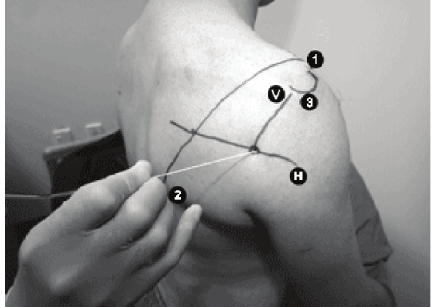
Figure 8: Price technique for the axillary nerve block. A line con- nects the anterior acromion (1) with the inferior angle of the scapula (2). The midpoint of the line represents the level of the hor- izontal axis (H) of the quadrilateral space. The line representing the vertical axis (V) is drawn down from the posterolateral aspect of the acromion (3) (Price [3]). (Reprinted with permission.)